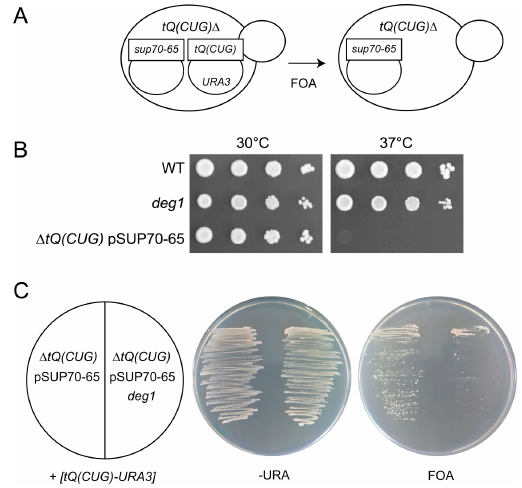
Figure 3. Role of ψ 38 for the sup70-65 allele of the tQ(CUG) gene. ( A ) Experimental design for